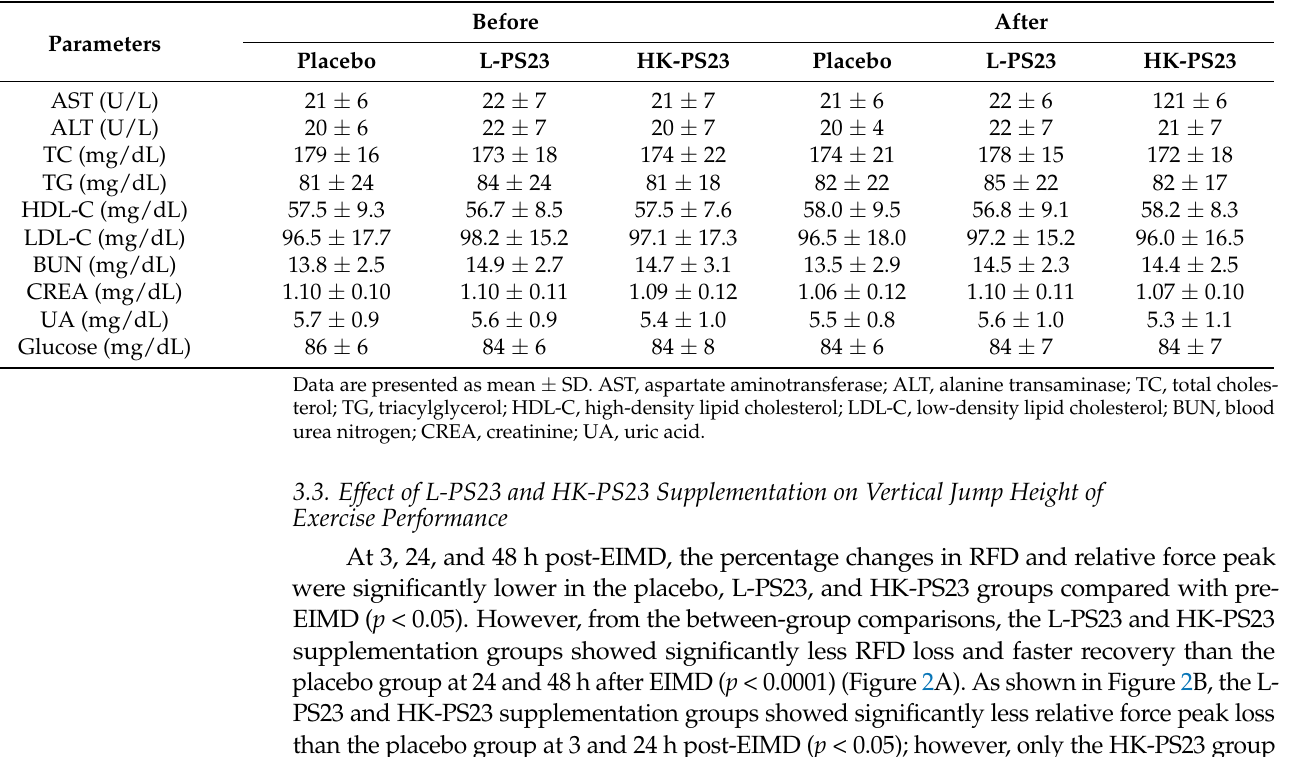
Table 4. Subject’s blood biochemical parameters before and after the 6-week L-PS23 and HK-PS23 intervention.